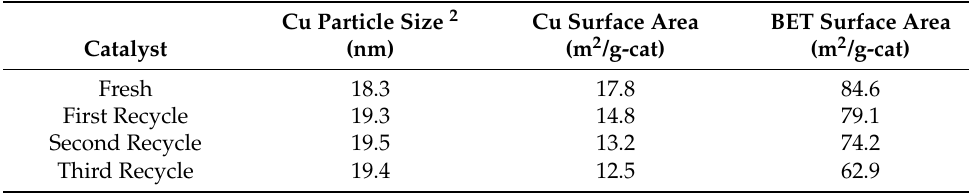
Figure 9. XRD profiles of 2Pd-CZA catalysts: ( a ) reduced fresh catalyst; ( b ) first time recycle; ( c ) second time recycle; ( d ) third time recycle. Spent catalysts were not reduced. Cu/Zn/Al (molar) = 35/35/30. All traces have been displaced for clarity. Table 5. Physicochemical properties of recycled catalysts 1 .